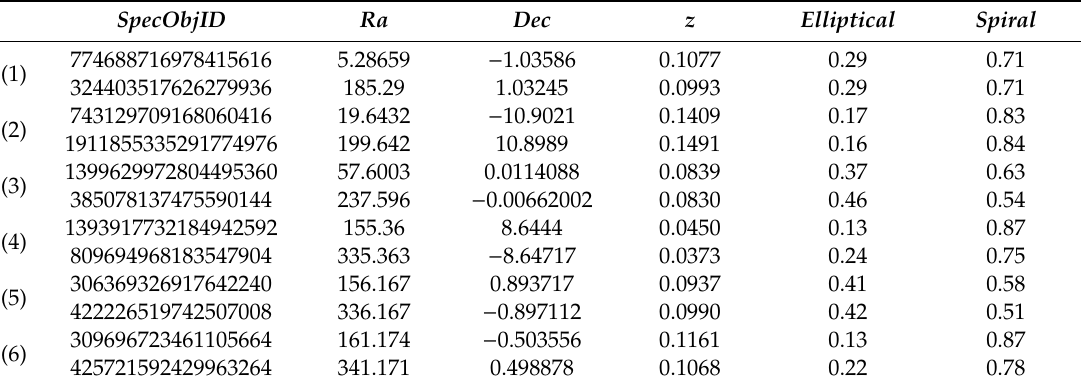
Table 9. Pairs of spiral galaxies for the e ff ect of cosmic mirror [39]. Accuracy is of 0.005 ◦ for ra and dec and 0.01 for z . SpecObjID is ID of optical spectroscopic object in SDSS.